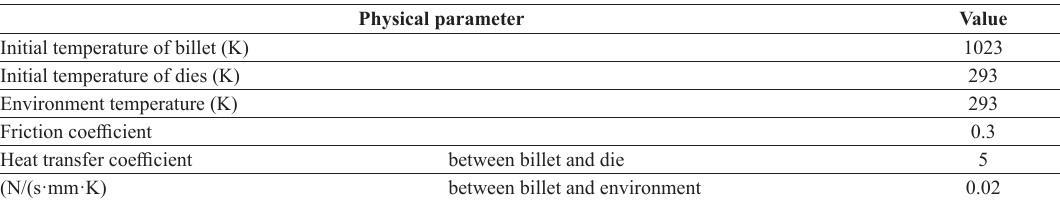
Figure 14. The simulation results of the hot forming process of the V-shaped part: (a) distribution of the effective plastic strain and (b) forming load with top die Table 1. Physical parameters of finite element simulation.